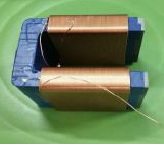
Figure 4. Test system.